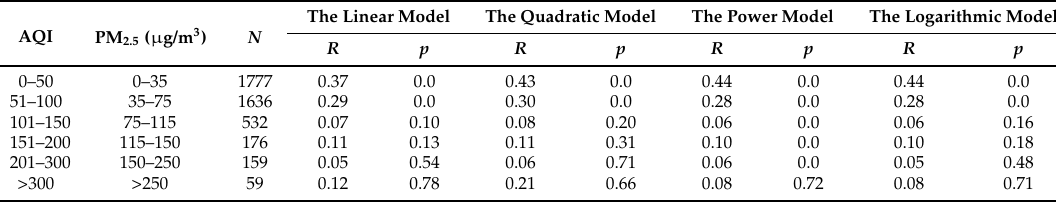
Table 2. Comparison of the four models based on the different criteria of the AQI. The Linear Model The Quadratic Model The Power Model The Logarithmic Model N R p R p R p R